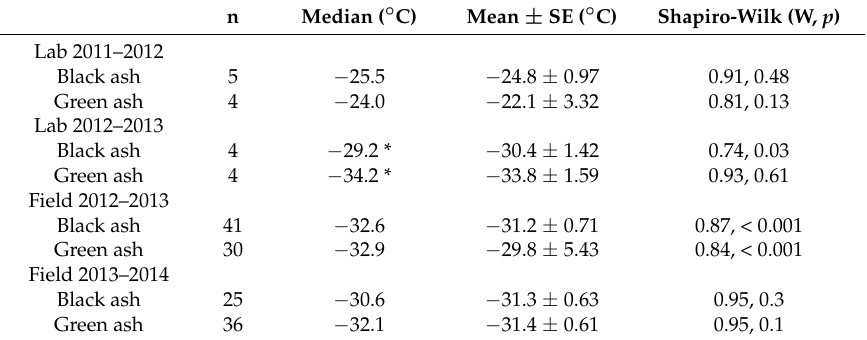
Table 1. Median and mean ( ± SEM) supercooling points for larvae from green and black ash that were artificially infested (lab) or naturally infested (field) during the winters of 2011–2012, 2012–2013, or 2013–2014. n Median ( ◦ C) Mean ± SE ( ◦